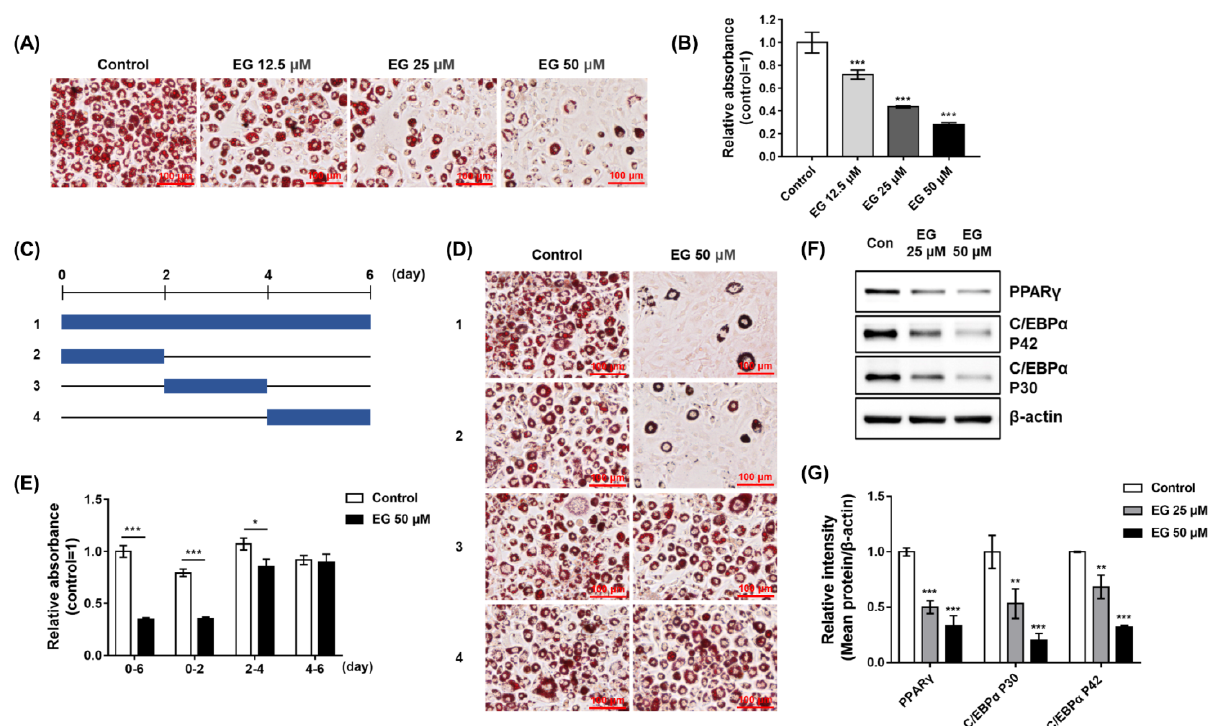
Figure 7. Anti-adipogenic effect of ethyl gallate (EG) at the early stage of differentiation. Preadipocytes of 3T3-L1 cells were differentiated by DMI-induction (DMI: dexamethasone, methylisobutylxanthine, and insulin) and treated with various concentrations of EG (12.5 µ M, 25 µ M, and 50 µ M) simultaneously. To analyze which stages are affected by the treatment with EG, 3T3-L1 cells were treated with 50 µ M EG for 0–6 days (1), 0–2 days (2), 2–4 days (3), or 4–6 days (4) during DMI-induced differentiation ( C ). On day 6 of differentiation, lipid droplets of 3T3-L1 adipocytes were stained using the Oil red O working solution and visualized. Scale bar, 100 μ m ( A , D ). Quantitative data on the lipid content were analyzed using extracted Oil red O with 100% isopropanol ( B , E ). For analysis of early adipogenic factors, cells were lysed and analyzed by Western blot using anti ‐ PPAR γ , C/EBP α , and β‐ actin antibodies after treating with EG for 48 h during DMI ‐ induced differ ‐ entiation ( F ). Quantification was performed, and each was normalized to control using CSAnalyzer 4 ( G ). Data are shown as mean ± standard deviation ( n = 3). * p < 0.05, ** p < 0.01, *** p < 0.001. Statistical significance was analyzed by one ‐ way ANOVA for multiple comparisons followed by Tukey–Kramer statistical test.